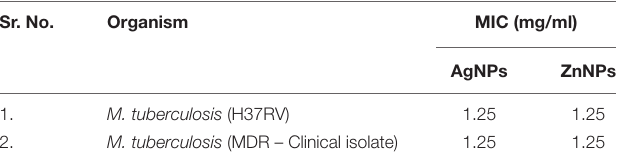
TABLE 2 | MIC of nanoparticles against standard and MDR strain of Mycobacterium tuberculosis. Sr. No.